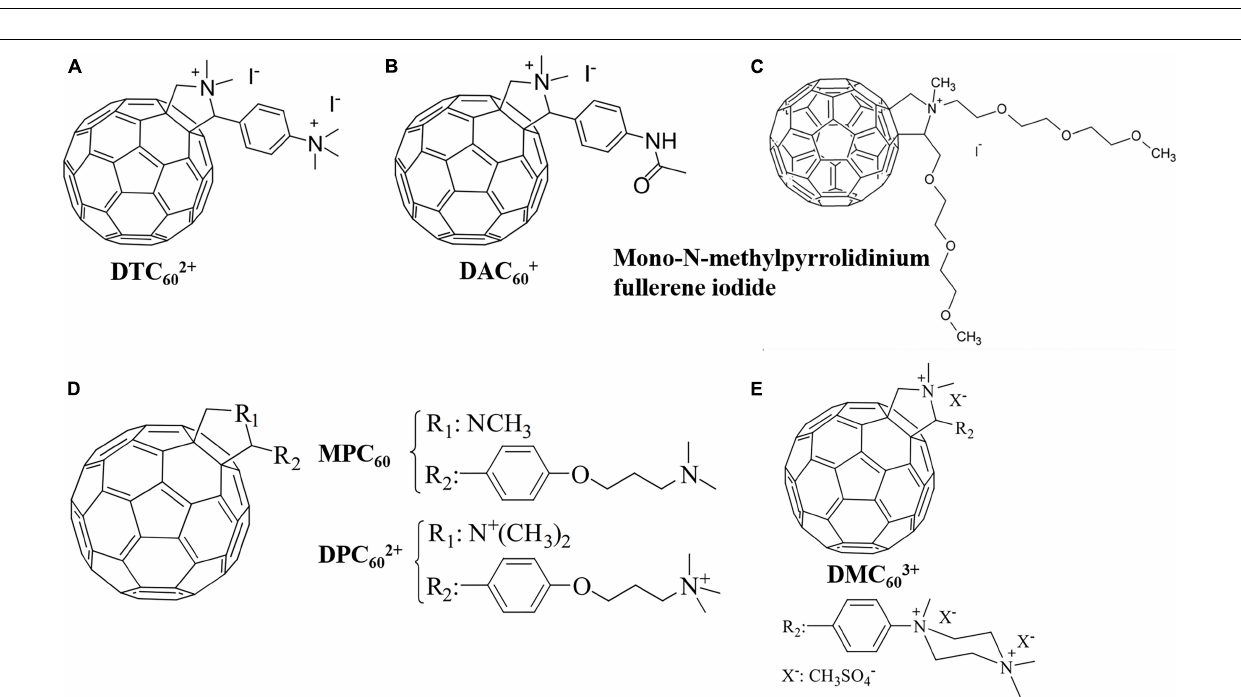
FIGURE 3 | Molecular structures of the fullerene-pyrrolidine derivatives. (A) DTC 602 + . (B) DAC 60 + (Spesia et al., 2008). (C) Mono-N-methylpyrrolidinium fullerene iodide (Grinholc et al., 2015). (D) MPC 60 and DPC 602 + (Agazzi et al., 2015). (E) DMC 603 + (Agazzi et al., 2021).